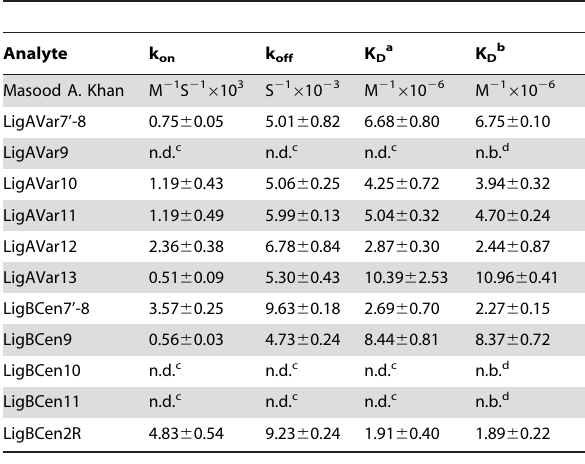
Table 1. The dissociation constants and kinetic data of GBD- Lig interactions determined by ELISA and SPR.